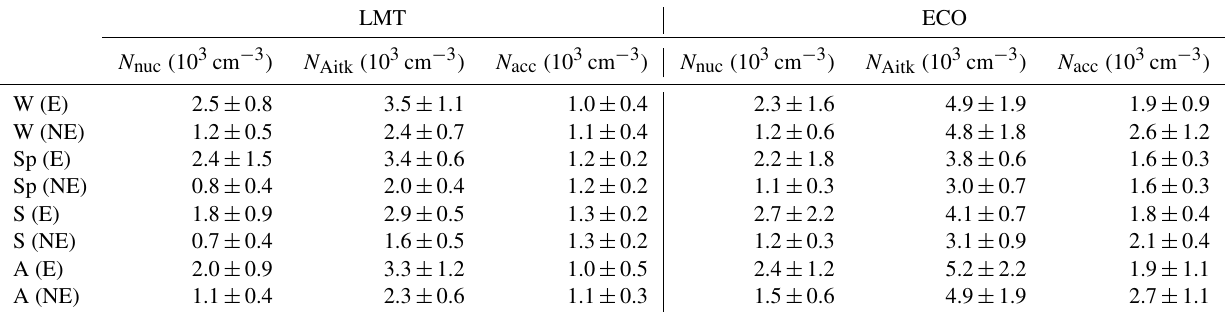
Table 3. Arithmetic means ± 1 standard deviation of nucleation, Aitken, and accumulation PNC (cm − 3 ) related to event days (E) and non-event days (NE) for each season (winter, W; spring, Sp; summer, S; and autumn, A) and for both